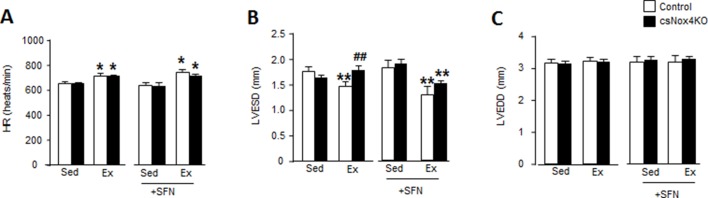
csNox4KO mice exhibit reduced cardiac function at peak exercise.Cardiac function was evaluated by awake echocardiography prior to (sedentary, Sed) and after the exercise capacity test (Ex). Some animals were treated with sulforafane (SFN). Mean data of heart rate (HR), left ventricular end-systolic dimension (LVESD) and left ventricular end-diastolic dimension (LVEDD) (A to C). *p<0.05, **p<0.01 vs respective sedentary controls, ##p<0.01 vs Control/Ex, 2-way ANOVA followed by Tukey post hoc analysis (n = 4–12/group).